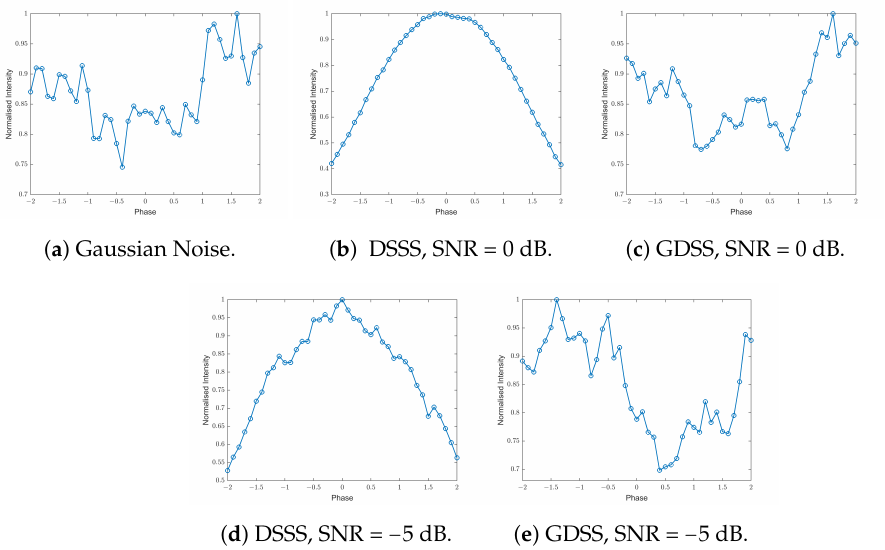
Figure 9. Phase angle modulation stripping detector with QPSK, normalised intensity versus phase, N =